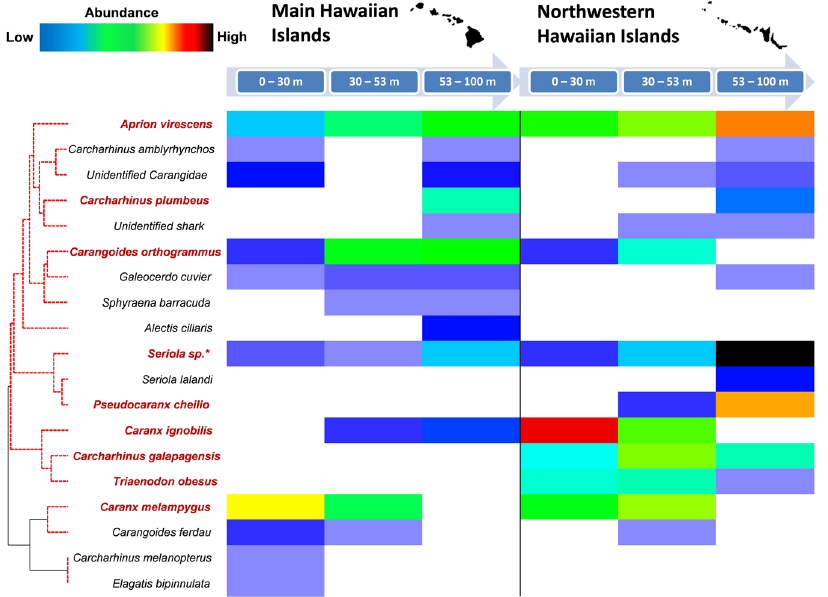
Figure 4. Shade plot showing regional (MHI, NWHI) and depth distributions of all roving predator species. Raw species relative abundance values ( MaxN , hr − 1 : color ramped blocks) were square root transformed to down-weight more abundant species. Y-axis (roving predator resemblance): position of standardized MaxN , hr − 1 predator values, ranked by Whittaker’s Index of Association transformation and Group Average Hierarchical Cluster analysis (Type III SIMPROF, with permutation between sites). Red dotted lines: groups of coherent species. Species identified in SIMPER highlighted in red. (b) X-axis: Sites grouped according to region (MHI, NWHI) and depth strata, aligned from left to right. Shade plot generated in PRIMER 7.0.11 (http:// www.primer-e.com/). Maps in the figure were generated using Adobe Illustrator CS5 (https://www.adobe.com/